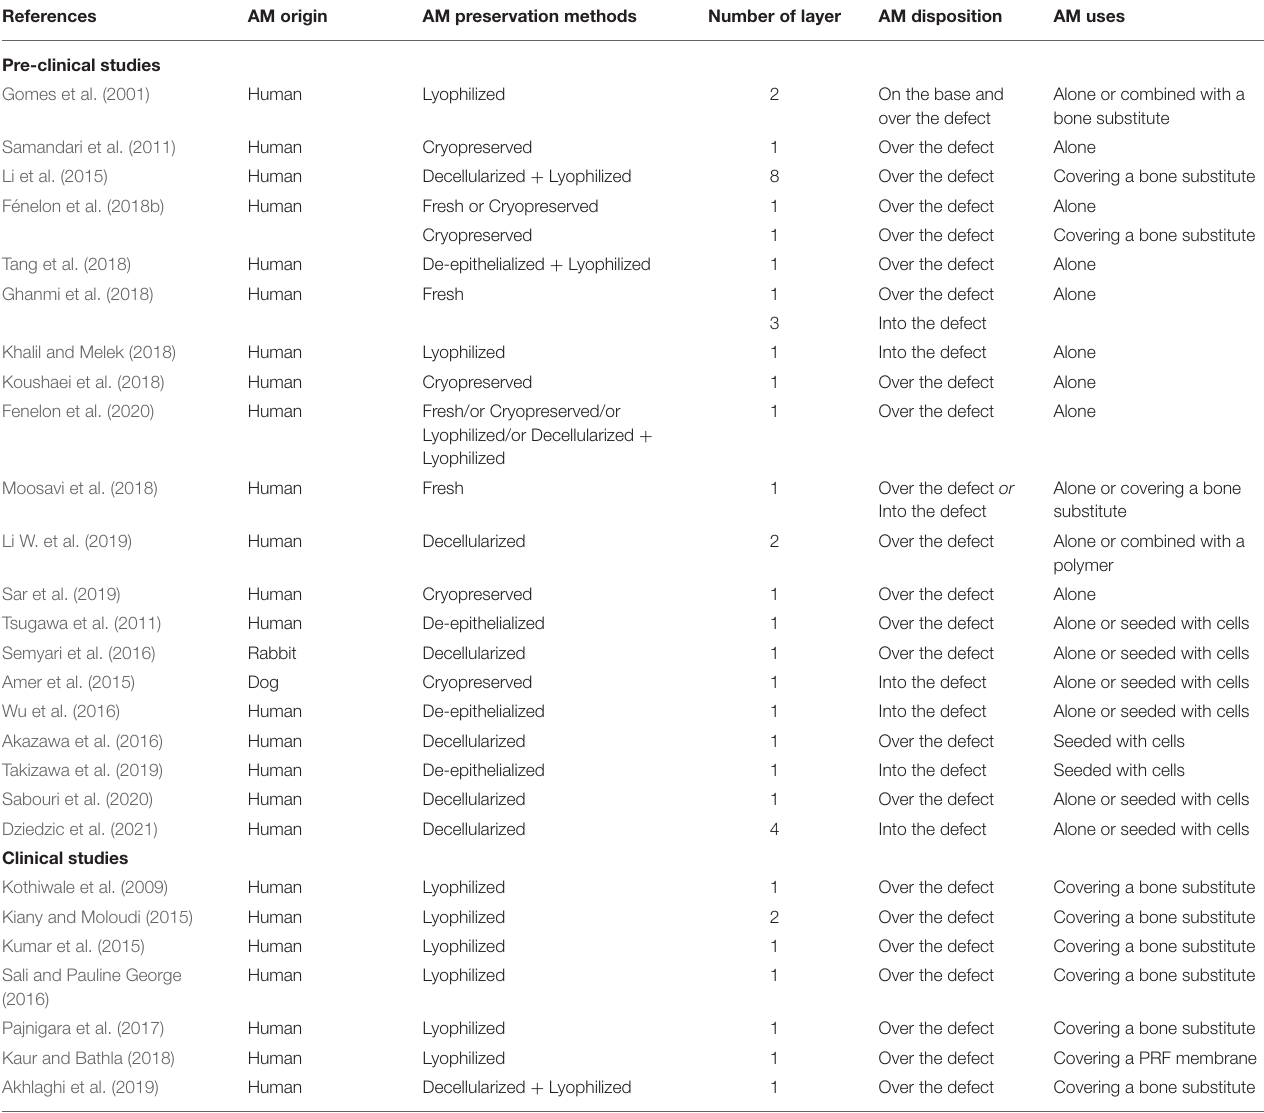
TABLE 1 | AM usage strategies to treat bone defects in preclinical and clinical